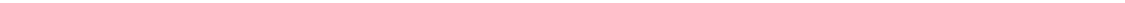
(Fig. 6 continued). (A) Double MARK4S (green) and (cid:3) -tubulin (red) immunostaining of the MI-60 cell line showing the colocalisation of the kinase with the midbody (yellow arrow) and centrosomes (white arrow) near the nucleus. (B) In G-91 cells, MARK4S does not exhibit colocalisation with the nucleoli, identified by the nucleolin red signals. (C–E) Co-labelling of both MARK4 isoforms (green) and nucleolin (red) in normal cells. (C) MARK4S does not colocalise with the nucleoli in ReNcellCX. MARK4L does not localise to the nucleoli of (D) adult fibroblasts or (E) myoblasts. (F) MARK4S and (G–H) MARK4L (green) colocalise with (cid:3) -tubulin (red) in the midbody and centrosomes of matched normal cells. (I–L) Representative images of MARK4L immunofluorescence in human GBM CSCs and mouse NSCs. Double- immunostaining of MARK4L (green) and nucleolin (red) in GBM CSCs shows (I) strong MARK4L signals in the differentiated progeny and (J) a faint labelling of the kinase in the nucleoli of undifferentiated GBM CSCs. (K and L) MARK4L is not detectable in the nucleoli of either differentiated or undifferentiated mouse NSCs. (M and N) Effect of RNase treatment on MARK4L and nucleophosmin (NPM) sub-cellular localisation in the MI-4 GBM cell line. (M) Absence of both MARK4L (green) and NPM (red) fluorescent signals in the nucleoli of RNase treated cells, while MARK4L midbody association is maintained. (N) Both MARK4L and NPM localise to the nucleoli of RNase-untreated cells. Nuclei are counterstained with DAPI. Magnification=63 ×